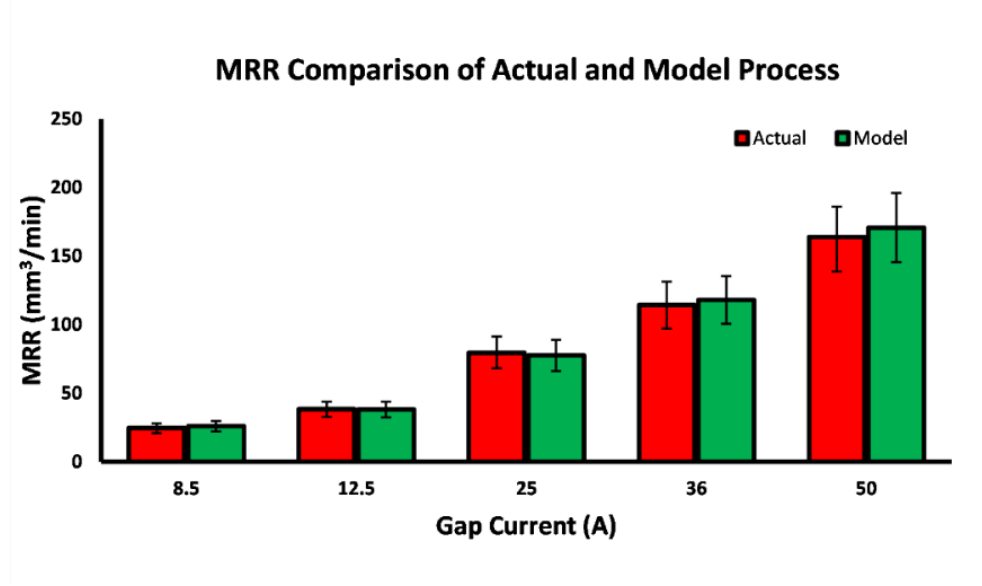
Figure 8. Material removal rate ( MRR ) comparison of the actual process and simulated modelling.